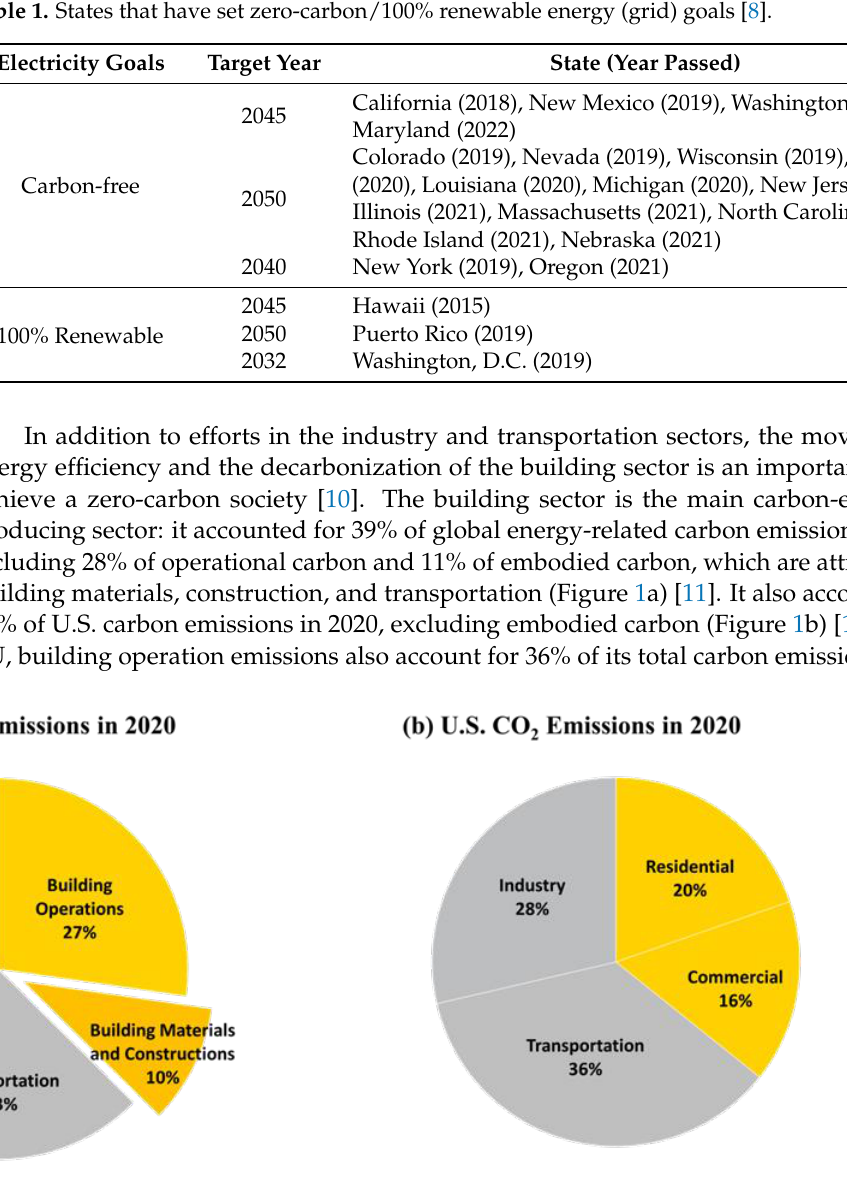
Table 1. States that have set zero-carbon/100% renewable energy (grid) goals [8]. Electricity Goals